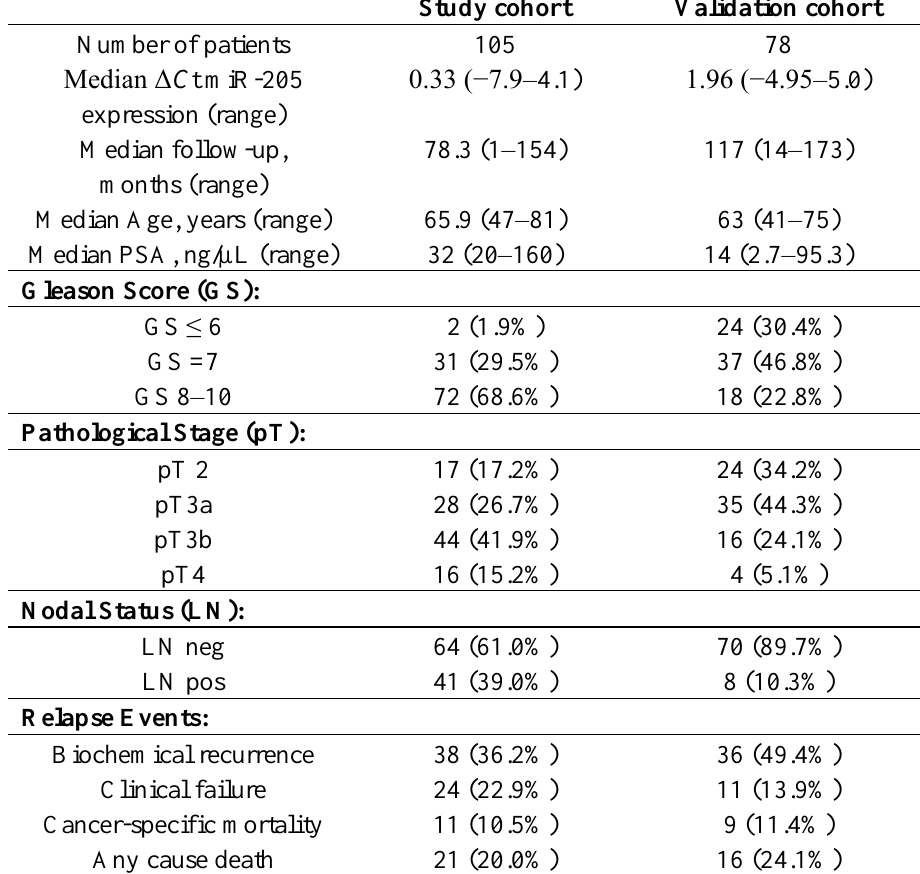
Table 1. Preoperative and postoperative patients’ characteristics of the HRPCa study cohort ( n = 105) and the HRPCa validation cohort ( n =